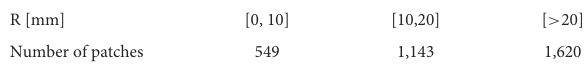
TABLE 1 The total number of image patches with different lesion sizes for the test (summation of all 9 count